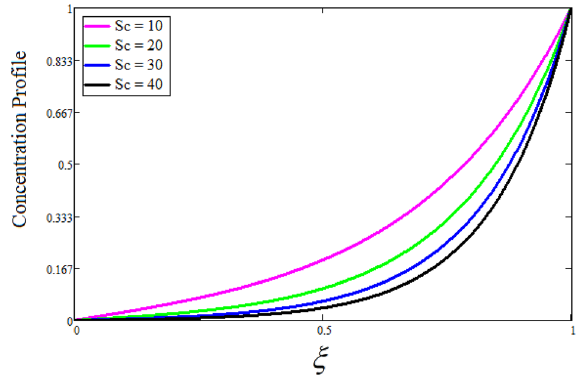
Figure 15. The consequence of Sc on the concentration distribution. Where φ = 0.01, α = 0.5, t = 1.